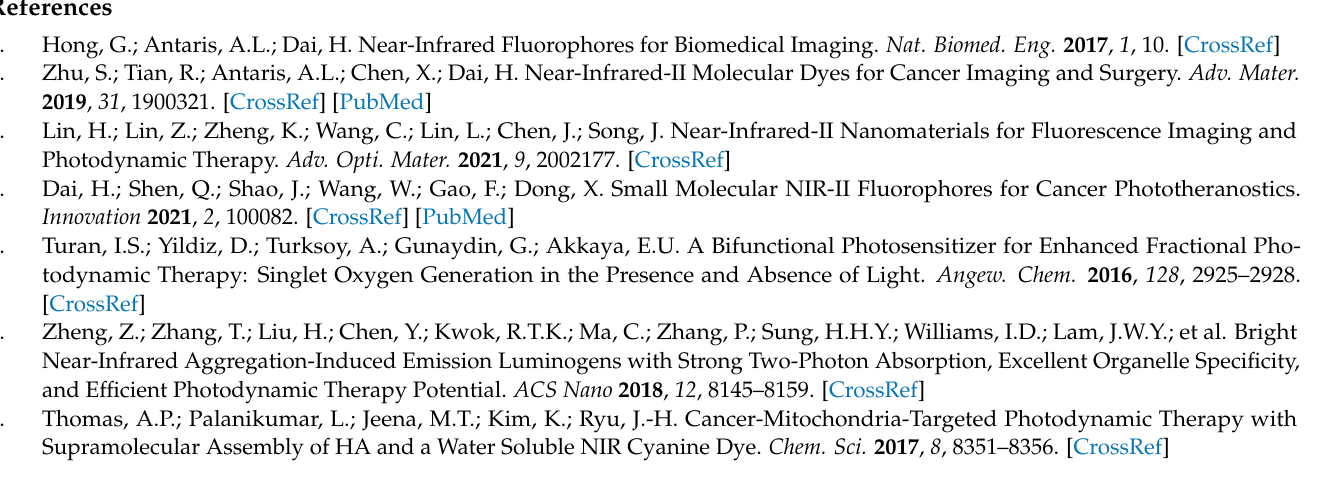
examination of mice; Figure S1: Optimization of BSA@Au; Figure S2: Fluorescent QY of BSA@Au; Figure S3: Penetration depth of NIR-I and NIR-II FL imaging; Figure S4: Photostability of BSA@Au; Figure S5: Catalase-like activity of BSA@Au; Figure S6: Biosafety of BSA@Au; Figure S7: Ex vivo FL images; Figure S8: Temperature of mice during cancer PDT; Figure S9: Tumor inhibition of mice received different treatments; Figure S10: Body weights of mice during cancer PDT; Figure S11: In vivo NIR-II FL imaging for MRSA-infected mice; Figure S12: Body weights of mice during MRSA PDT; Figure S13: Temperature of mice during MRSA PDT. References [45–52] are cited in the Supplementary